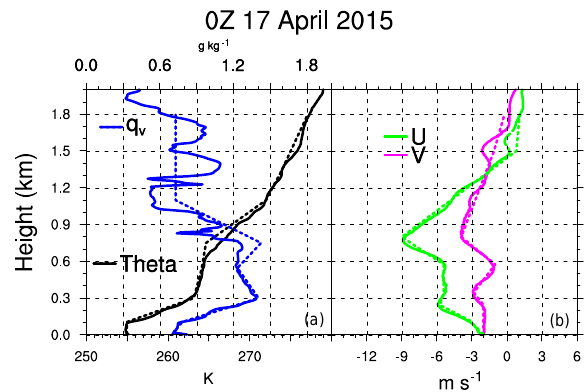
Figure 2. Sounding measured at 00:00UTC on 17 April 2015 at Oliktok Point, Alaska. (a) Water vapor mixing ratio ( q v ) and po- tential temperature (theta), in units of gkg − 1 and K, respectively. (b) Zonal wind ( U ) and meridional wind ( V ), in units of ms − 1 . The dashed lines show the initial profiles used in the WRFLES ex- periments. The dashed line overlying the water vapor mixing ratio is the initial profile for the total water mixing